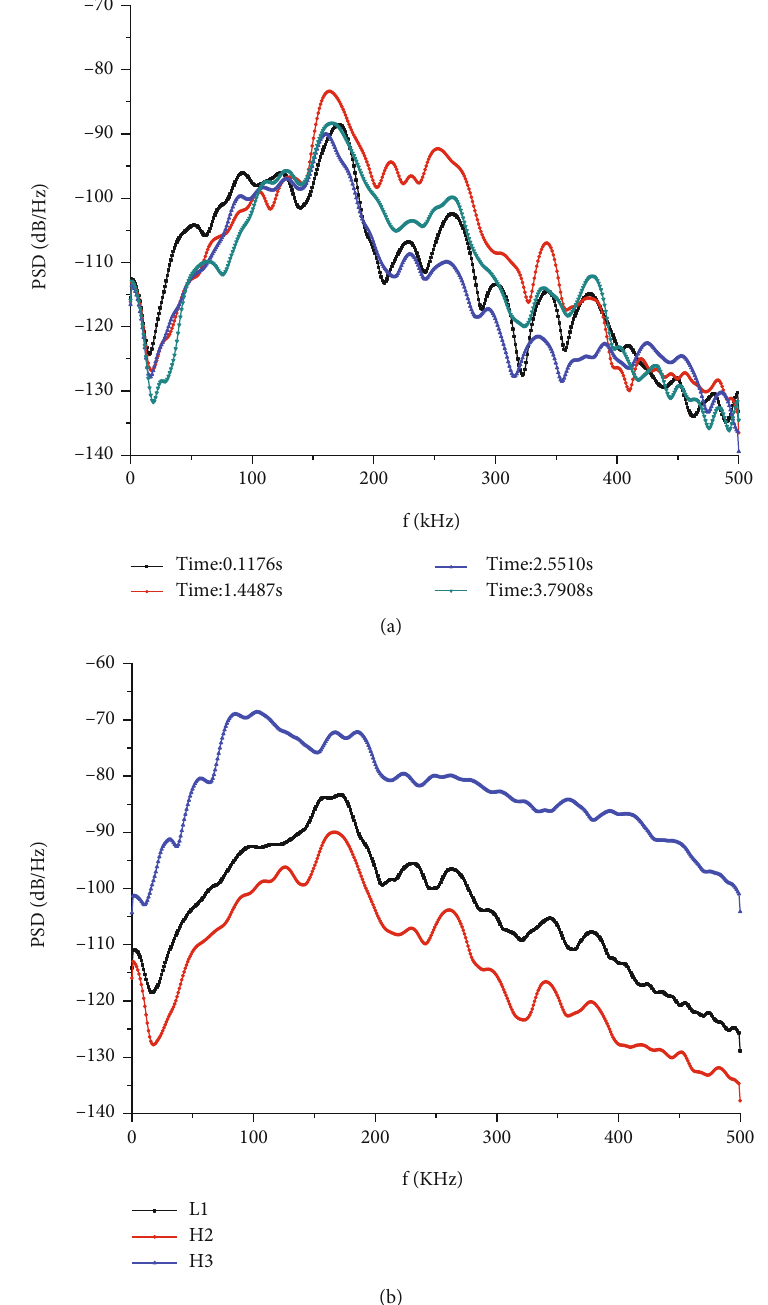
Figure 7: PSD characteristic curve: (a) PSD versus frequency at peak cutting force; (b) PSD versus frequency of three kinds of